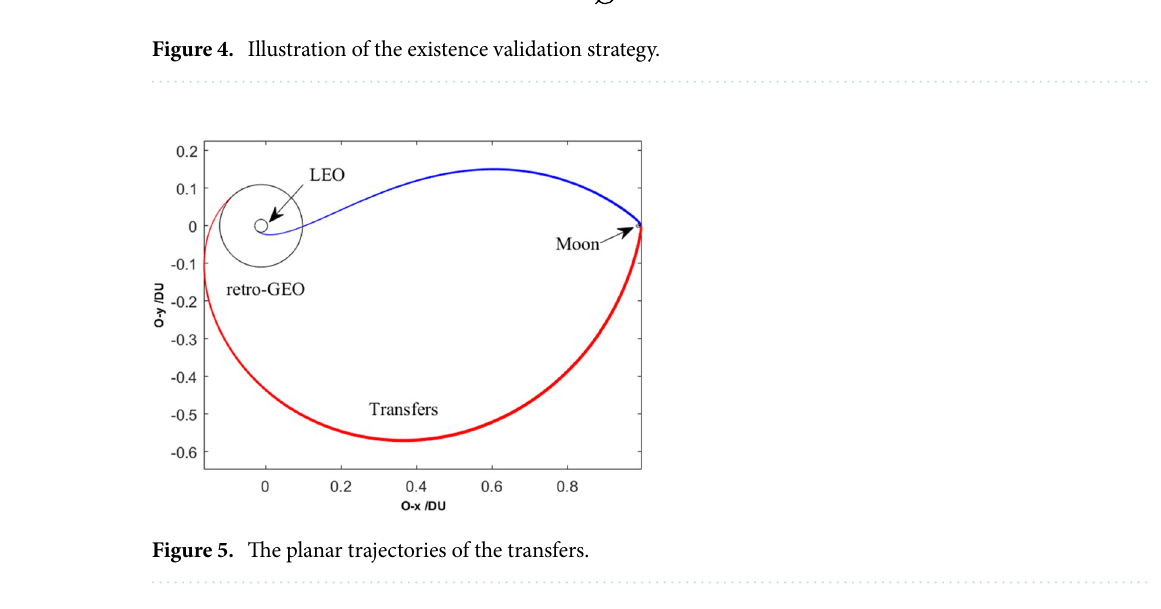
Computing orbit elements Results of Poincaré-section map